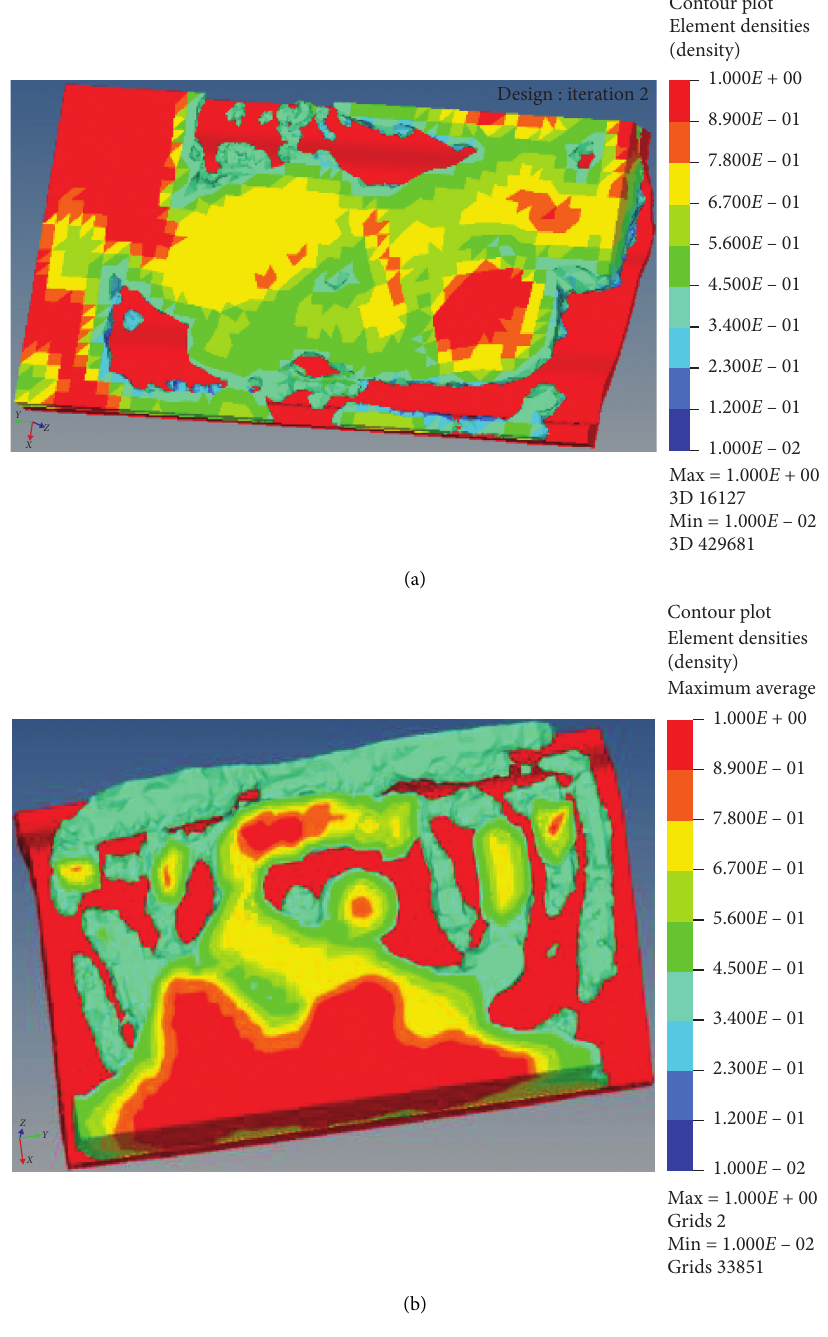
Figure 13: Topology optimization morphology. (a) Top mold topography. (b) Topology of the lower die.